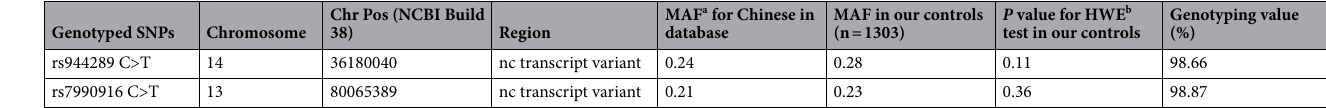
Table 3. LncRNA rs944289 frequencies were 29.55% (CC), 46.73% (CT) and 23.72% (TT) in CRC patients, whereas in controls, the distributions of those genotypes were 29.69%, 51.62% and 18.69%, respectively. We found that rs944289 TT homozygote was associated with decreased CRC risk when compared with the CC or CC + CT (TT vs. CC: adjusted OR = 0.88, 95% CI 0.78–0.99, P = 0.037; TT vs. CC + CT: adjusted OR = 0.86, 95%